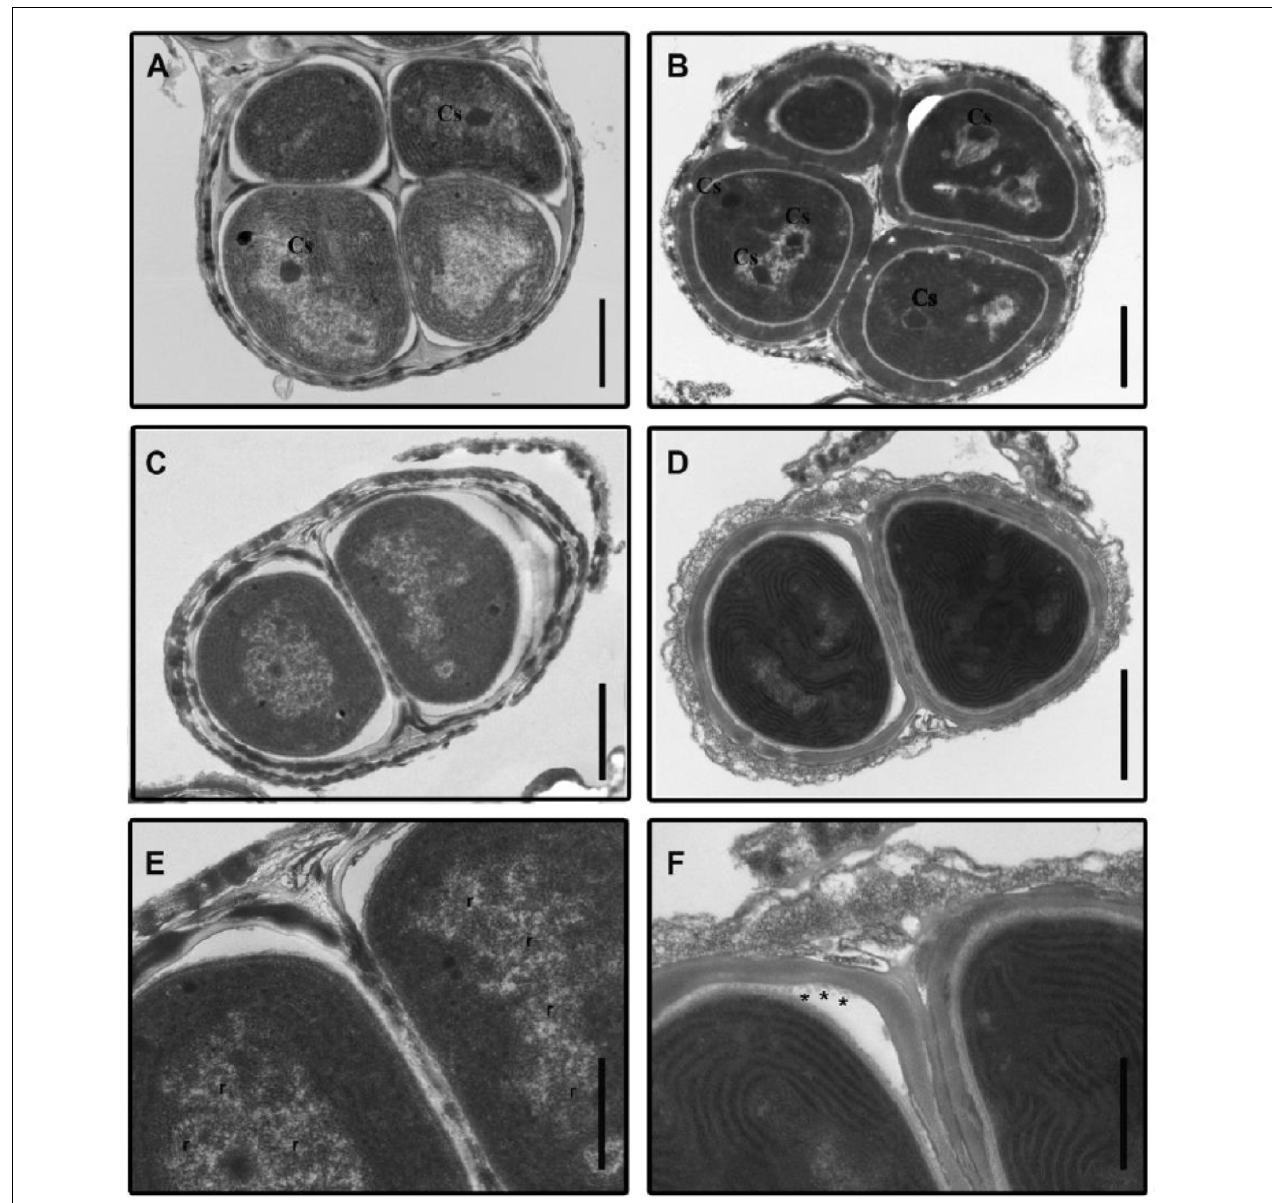
FIGURE 1 | Transmission electron micrographs of Gloeocapsopsis sp. UTEXB3054 cells before and after desiccation. (A) Characteristic tetrad from a liquid culture, before desiccation (initial condition). Cs, carboxysome. Scale bar: 1.0 µ m. (B) Characteristic tetrad after 3 weeks of desiccation. Scale bar: 1.0 µ m. (C) A binary group of cells at the initial condition. Scale bar: 1.0 µ m. (D) A binary group of cells after 4 weeks of desiccation. Scale bar: 1.0 µ m. (E) Photomicrograph showing details of (C) . The thylakoid membranes are arranged in parallel in the cell periphery. r: presence of ribosomes. Scale bar: 0.5 µ m. (F) Photomicrograph showing details of (D) . Asterisks indicate the presence of vesicles 0.5 µ